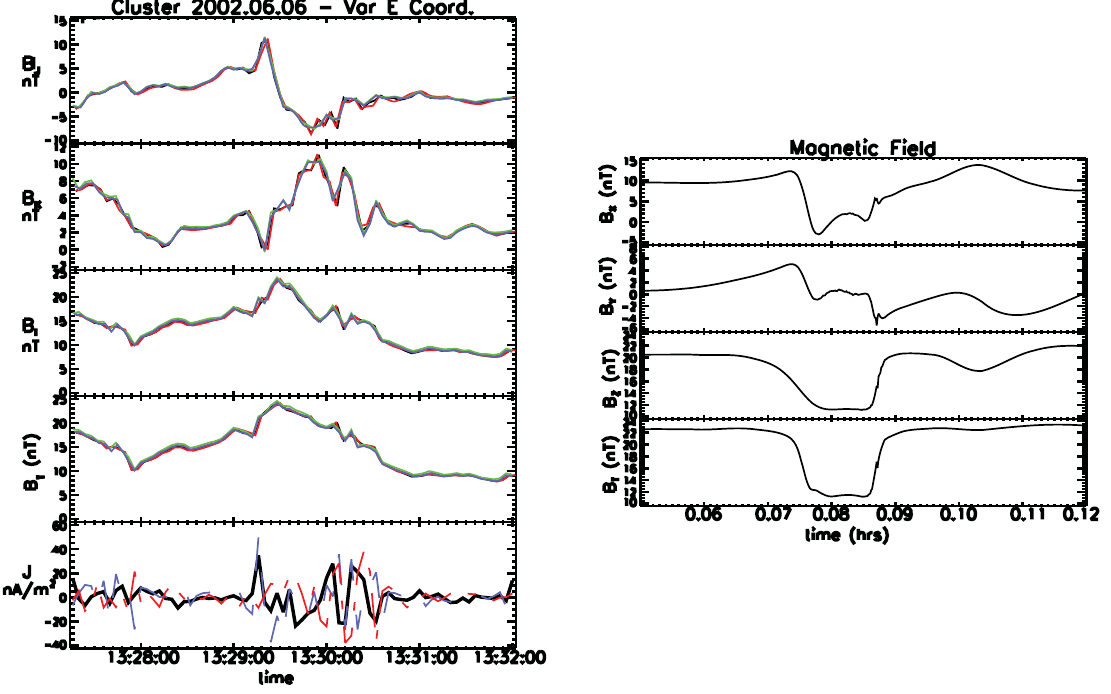
Fig. 6. Cluster and simulation magnetic field data for Event 3. The windows on the left display Cluster data in boundary-normal coordinates, used to determine the MSH and MSP values for the local MHD model. In order, the four spacecrafts are represented by black, red, green, and blue colors. From the top, the plot displays components of magnetic field ( B J is the maximum variance (normal), B K is the intermediate variance, and B I is the minimum variance (tangential) component), total magnetic field, current density. The windows on the right display the MHD simulation data. From the top, the plot displays components of magnetic field and total magnetic field.